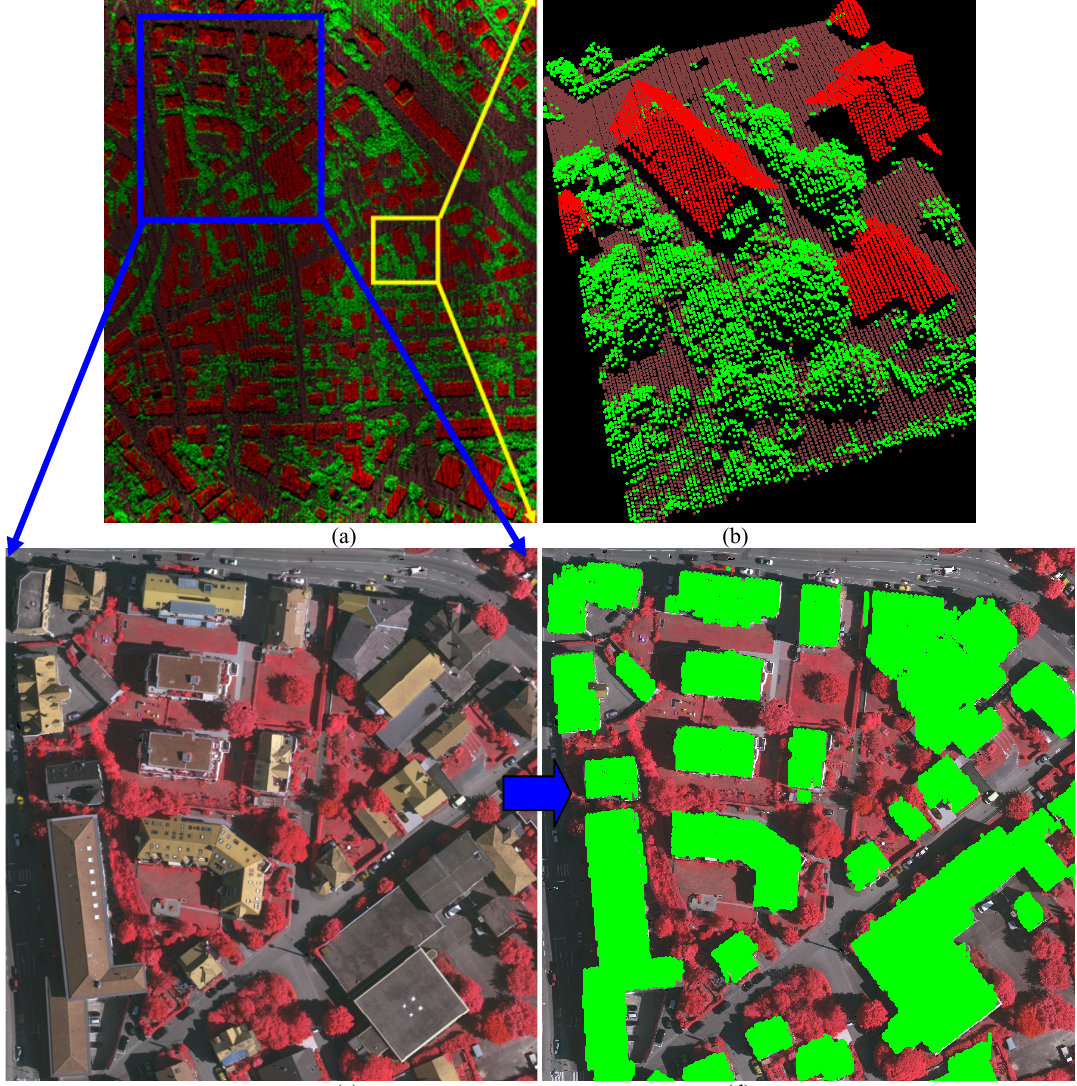
Figure 6: Extraction results of test area 2, (a) point cloud coloured by classification results (red: buildings, green: vegetation, brown: ground); (b) local enlarged view of (a) (3D view); (c) true ortho-photo of test area 2; (d) extracted building points (green) shown on the true ortho-photo.